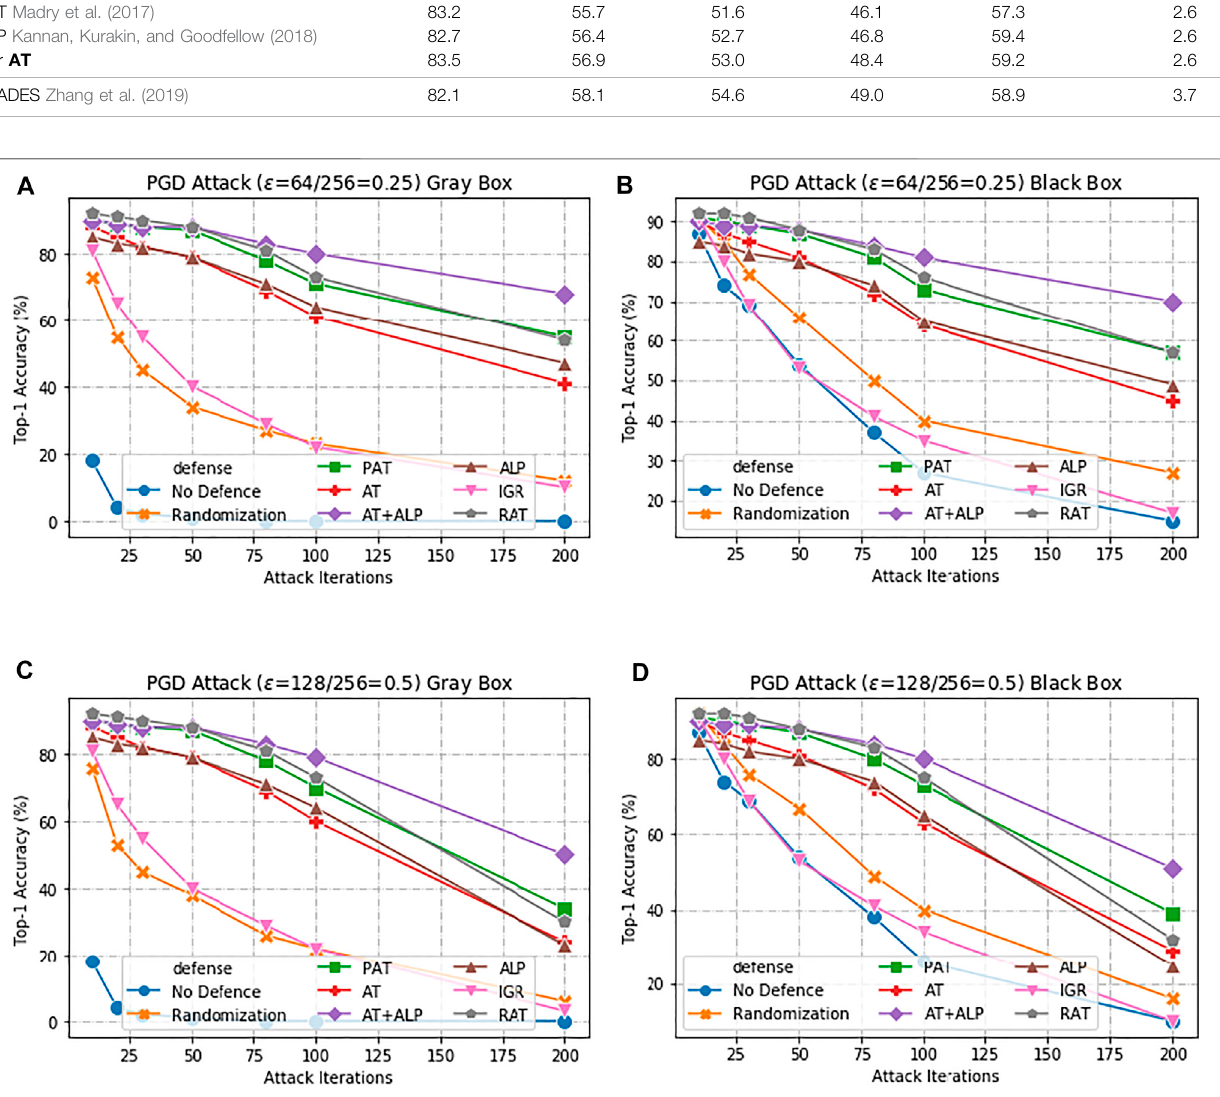
Frontiers in Arti fi cial Intelligence |